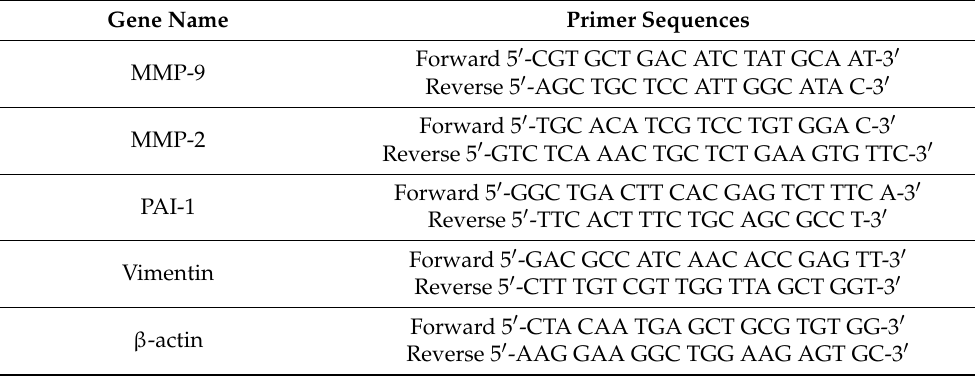
Table 1. Primer sequences used in the present